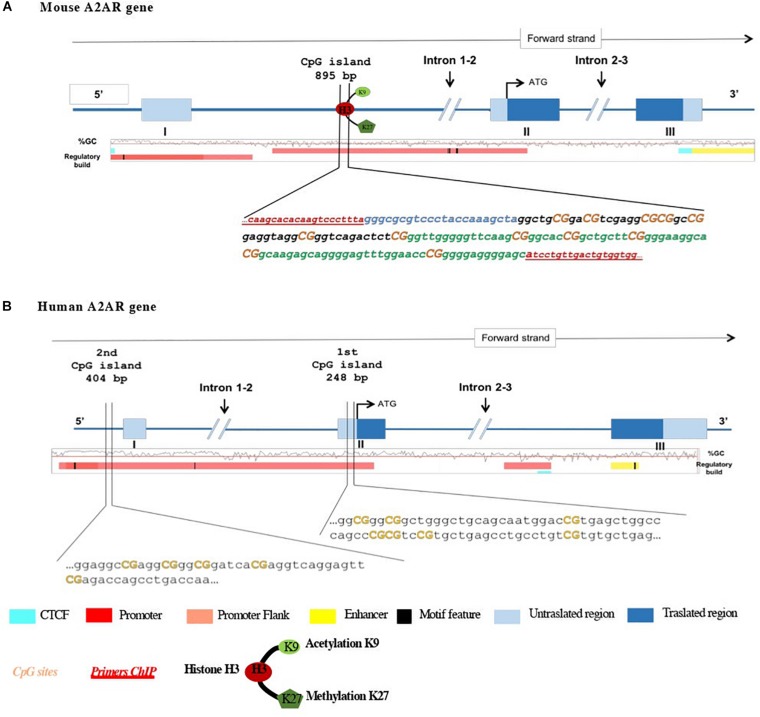
Schematic representation of (A) mouse and (B) human A2AR gene promoters and the 5′ upstream region. Translation start code (ATG), exons and introns, CpG island, and histone modifications studied are depicted. In mouse A2AR gene promoter, two regions (region 1 in black and region 2 in green) localized in the same CpG island. Orange bold text indicates the CpG sites analyzed.